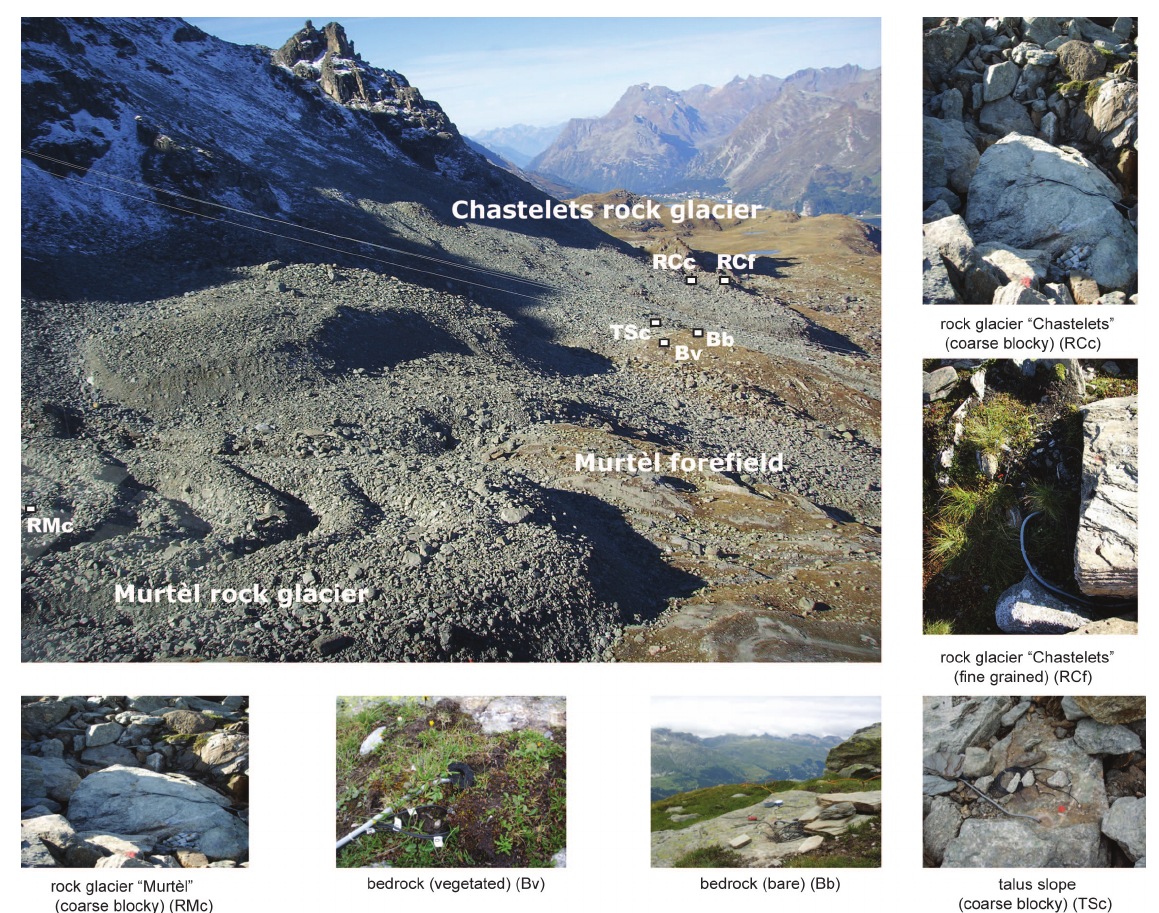
Fig. 2. Photographs of the different surfaces at the borehole locations in the investigation area, taken in summer 2009